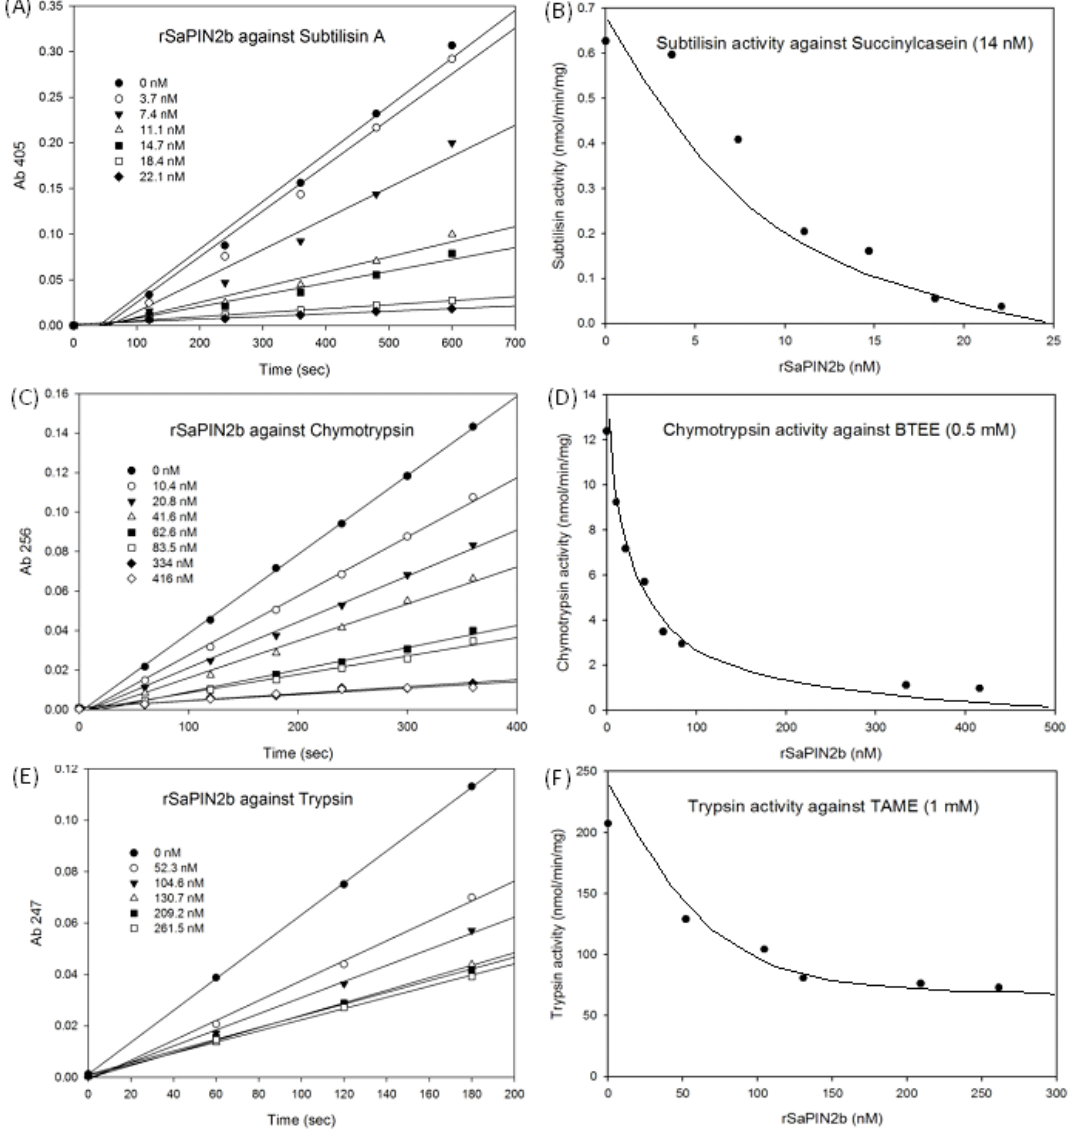
Figure 3. Analysis of the inhibition of various serine proteinases by rSaPIN2b. The time course of the inhibitory effect of rSaPIN2b against subtilisin ( A ), chymotrypsin ( C ) and trypsin ( E ). The remaining proteinase activity at the final reaction time point with different concentration of rSaPIN2b was shown in ( B ) for subtilisin, ( E ) for chymotrypsin, and ( F ) for trypsin, respectively. The substrates that were used in the assays were 14